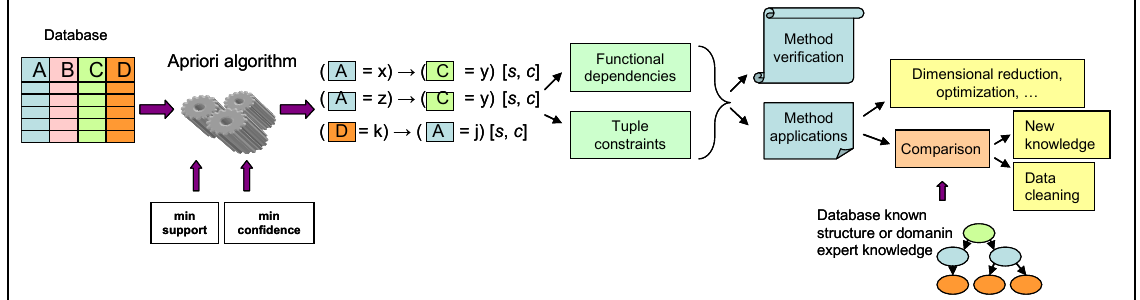
Figure 1 – Schema of the proposed framework If constraints and dependencies of a database are known, they can be used as criteria to evaluate its accuracy. If a tuple does not satisfy a tuple constraint or a functional dependency, its data is not correct. In biological databases such constraints and dependencies are often unknown or incomplete, due to the complexity of stored information. We propose a method to discover them by means of association rule